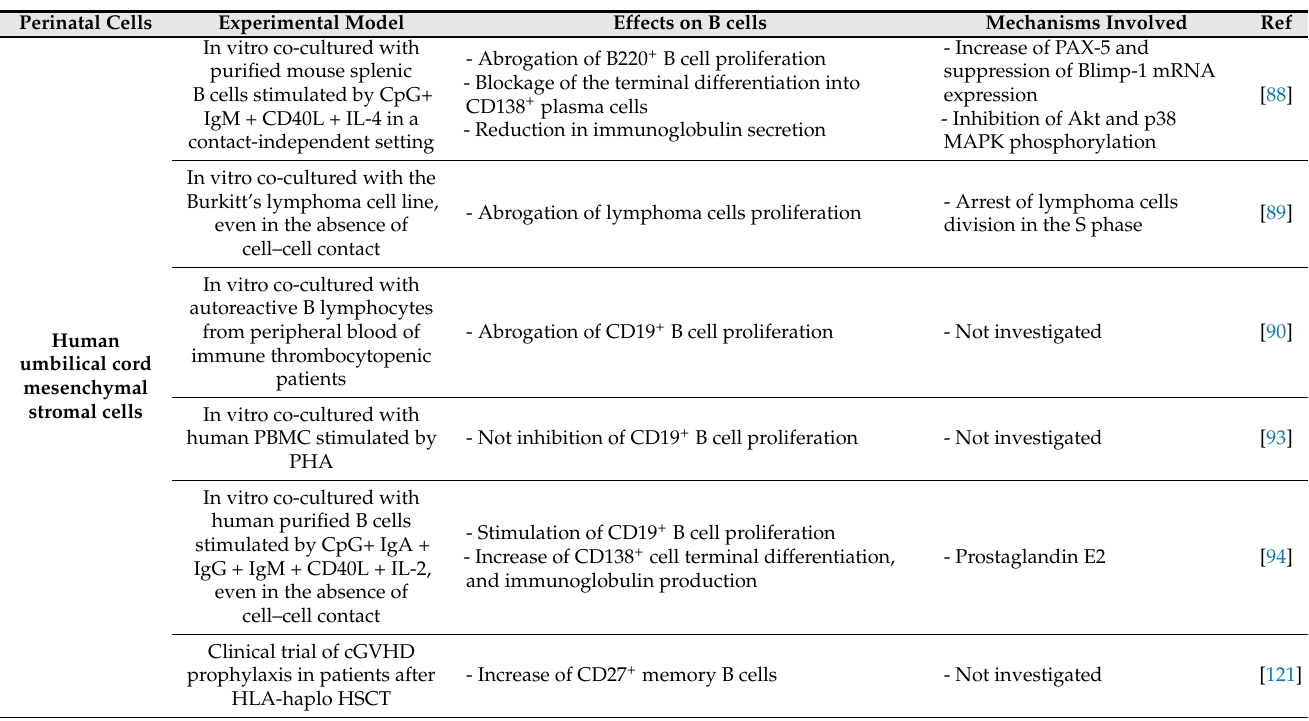
Table 1. Effects of perinatal cells on B